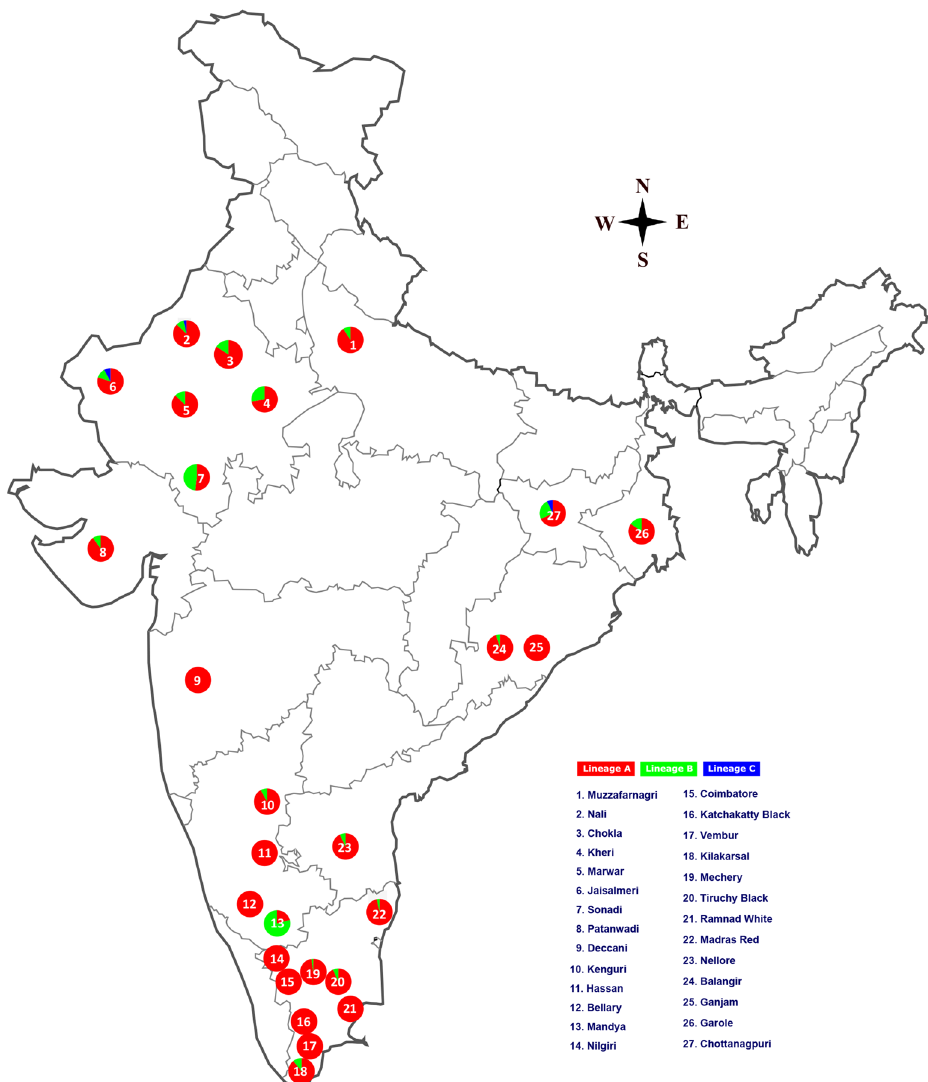
Figure 1. Map showing the sampling locations of sheep breeds and distribution of lineage A, B and C of Indian domestic sheep. The map (source: http:// www.d- maps. com/ carte. php? num_ car= 24853 & lang= en) was edited in Inkscape 1.0 (https:// inksc ape.